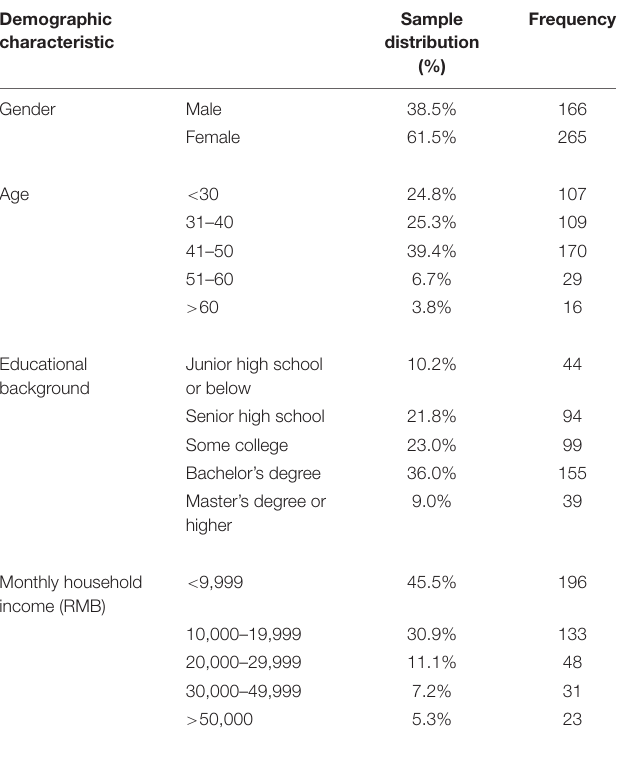
TABLE 1 | Descriptive statistics of participants.